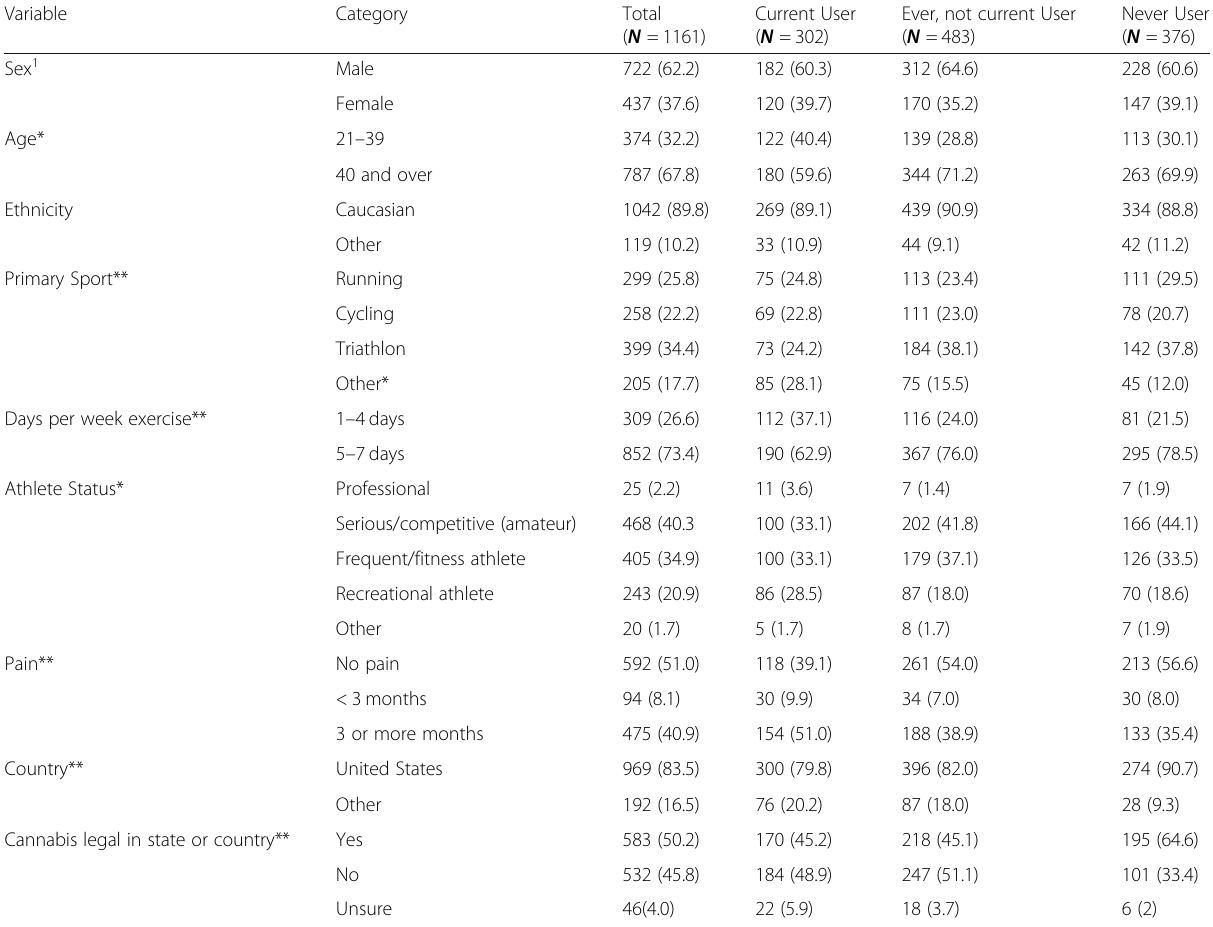
Table 1 Demographics by cannabis use status in 1161 adult athletes [Data as N (%)]*